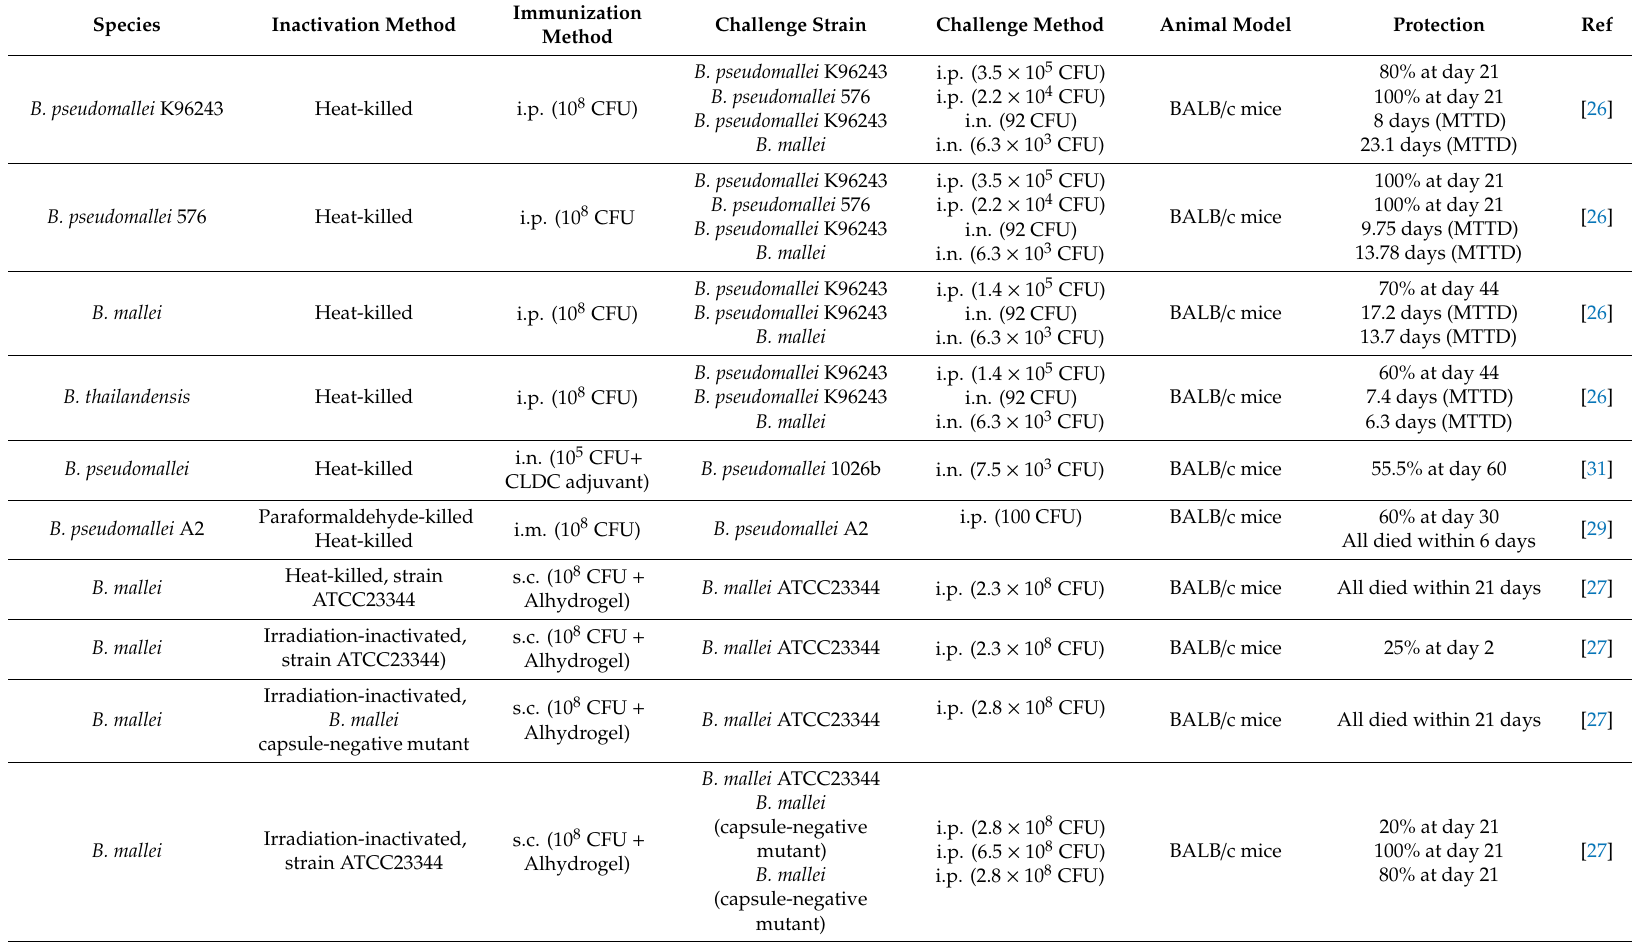
Table 1. Inactivated whole-cell vaccines a